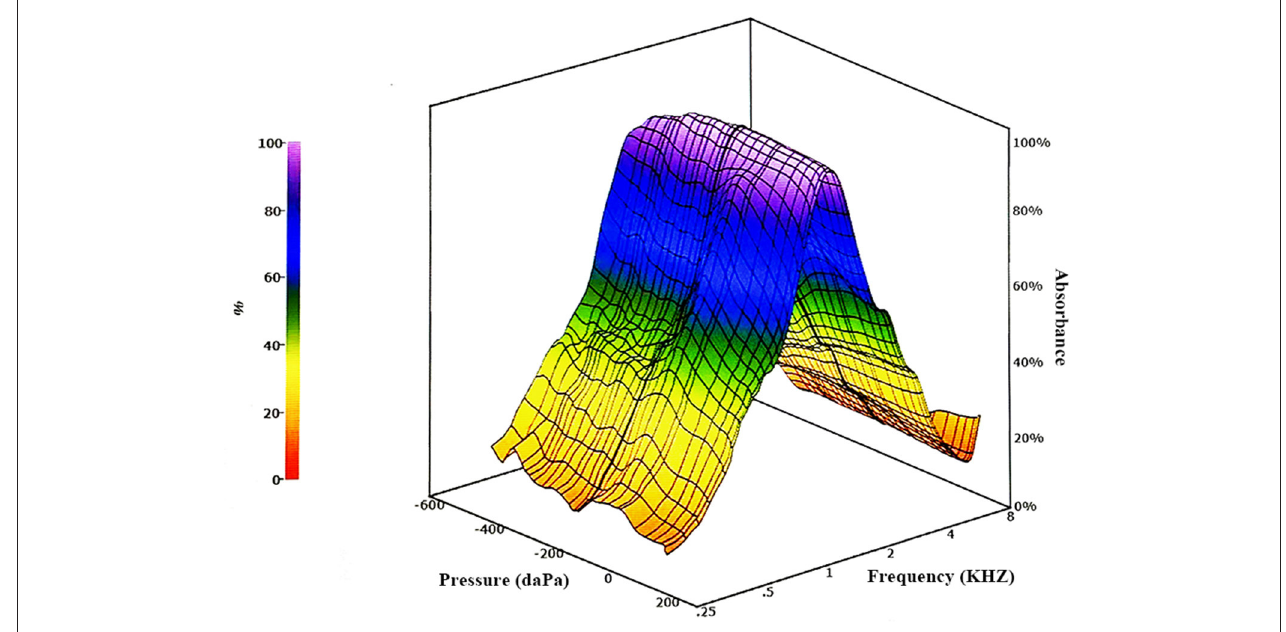
FIGURE 1 | Figure showing a three-dimensional broadband tympanometry image with simultaneous absorbance, frequency, and pressure data.